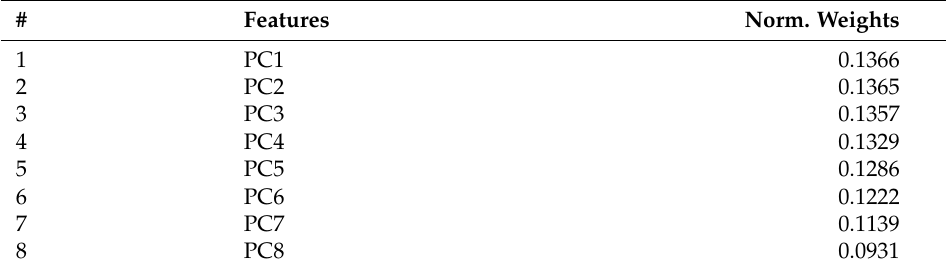
Table 4. Feature importance according to the PCA algorithm.